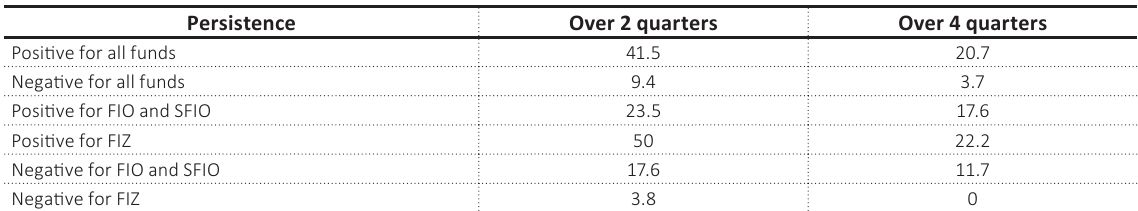
Table 5. Proportion of Polish quasi-hedge funds showing performance persistence in 2005–2017